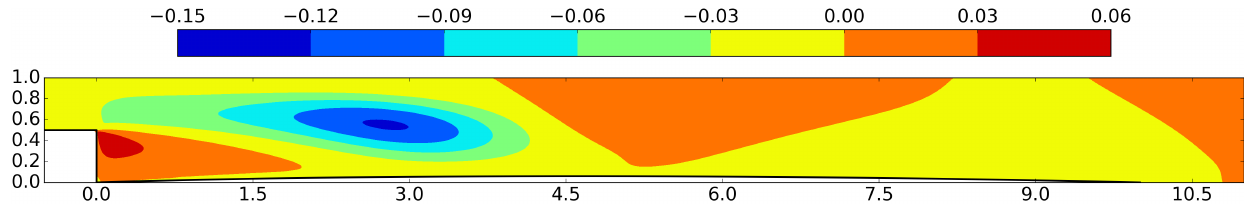
Figure 5. Longitudinal velocity profiles for successive positions x downstream of the step, for BFS with control portion l = 10 of elastic membrane bottom wall, with T m = 55 and p e = 0.525, under steady inflow at Re = 400 (0 ≤ x ≤ 17). The membrane shape is depicted also in non-dimensional units at the bottom (dashed line).